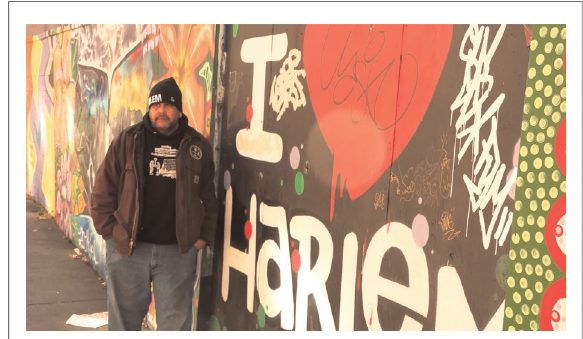
FIGURE 2 Screen capture from our intervention video depicting a peer educator who discusses the importance of COVID vaccination. All people who appear in the video, and the settings in which they appear, were selected after extensive input from participants and our community advisory board. Likewise, the messages people deliver onscreen were also developed with participant and CAB